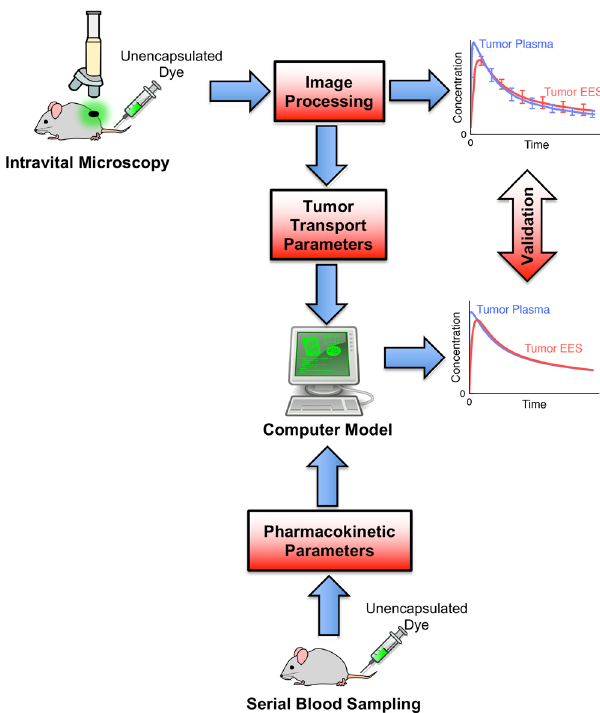
Fig. 6 Measurement of transport parameters and computer model validation with unencapsulated dye. Based on intravital studies with unencapsulated dye, tumor transport parameters were quanti fi